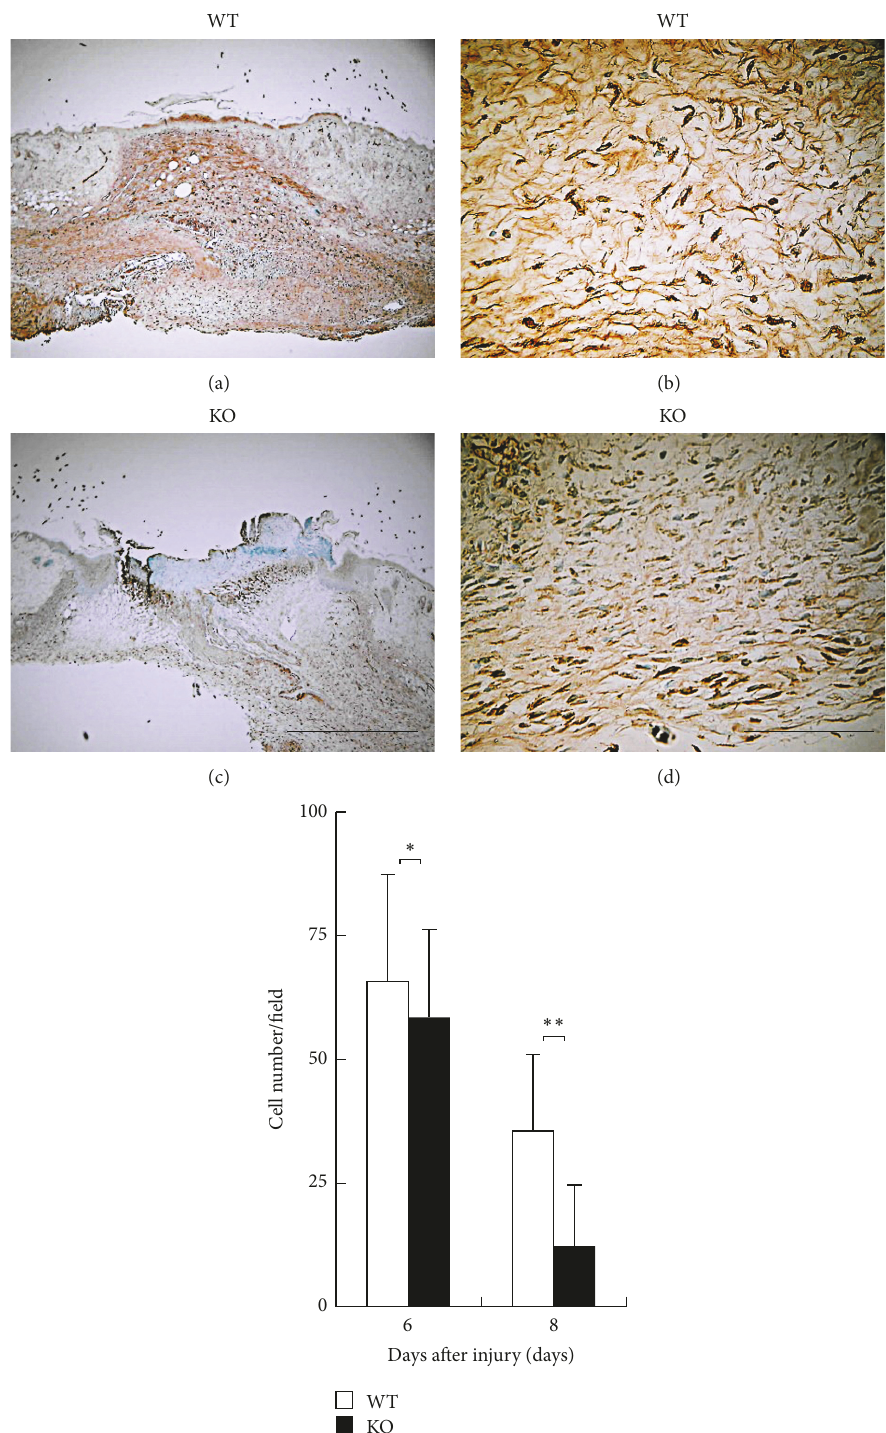
Figure 5: (a–d) Immunohistochemical observation of myofibroblasts as detected by 𝛼 -smooth muscle actin ( 𝛼 SMA). Skin wound samples of wild type (WT) (a, b) and inducible nitric oxide synthase (iNOS-) knockout (KO) (c, d) mice indicate findings at day 6 after injury. (e) The numbers of myofibroblasts within a wound bed were enumerated on these five visual fields and analyzed. The appearance of myofibroblasts as detected by 𝛼 SMA in KO mice was reduced with a statistical significance compared with WT mice at days 6 and 8 after injury. Open bars: WT, filled bars: KO (days 6, 8: 𝑛 = 7 animals in each group). Mean ± standard deviation. ∗ 𝑝 < 0.05 ; ∗∗ 𝑝 < 0.01 ; bar 10 𝜇